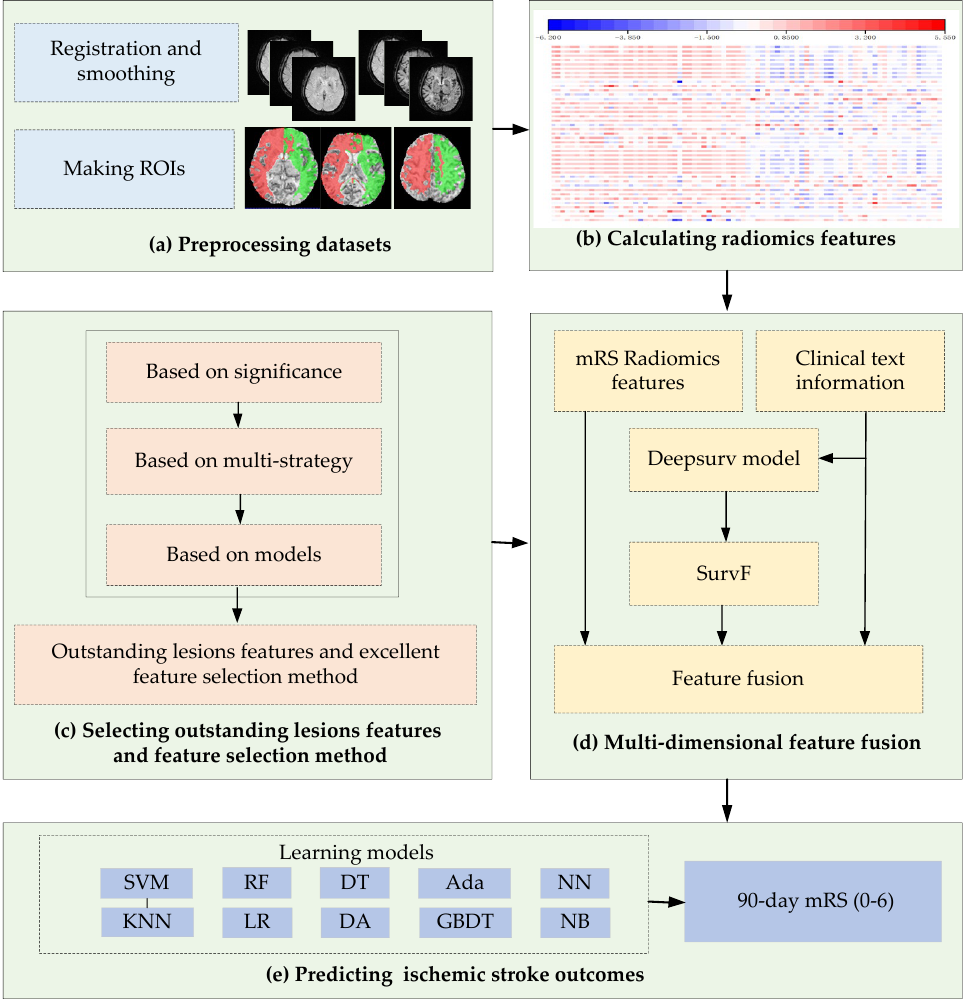
Figure 1. Flowchart of this study. ( a ) Process of the preprocessing of DSC-PWI datasets and making ROIs; ( b ) Calculating radiomics features, where the value of the feature is represented by color; ( c – e ) The process of feature selection, feature fusion, and stroke outcome prediction.